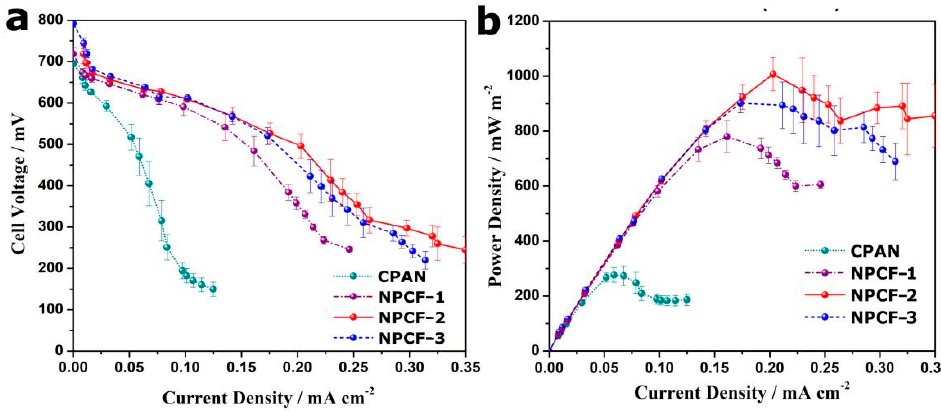
Figure 4. Polarization curves ( a ) and power curves ( b ) of different MFCs with five repeats.